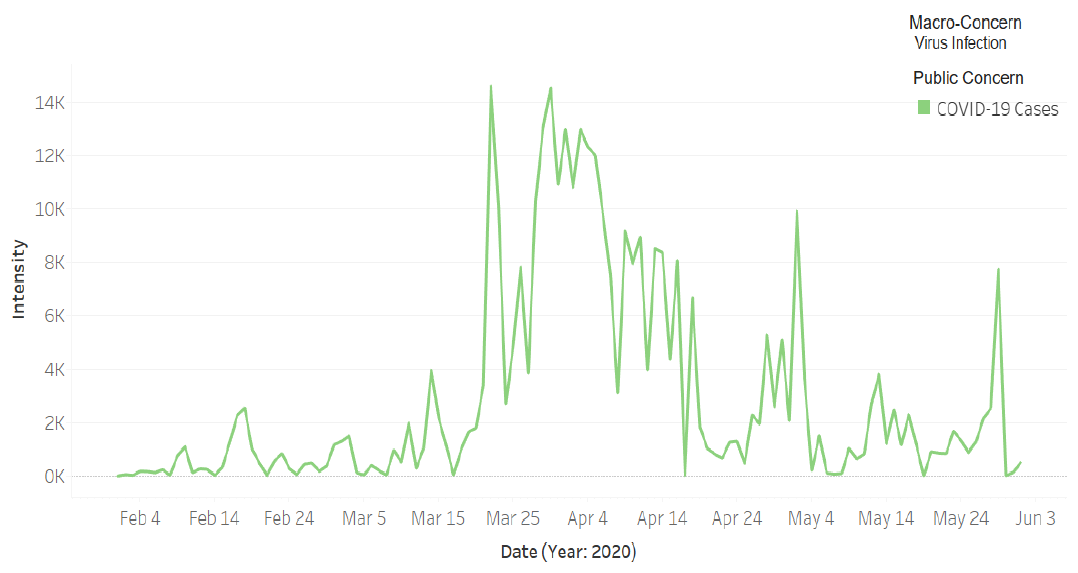
Figure 8. Daily Twitter activity for a macro-concern (virus infection).